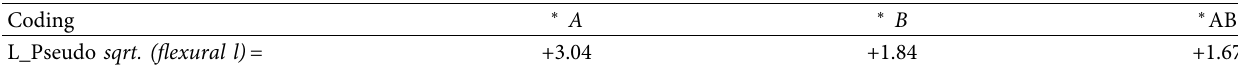
Table 22: Final equation in terms of L_pseudo components.